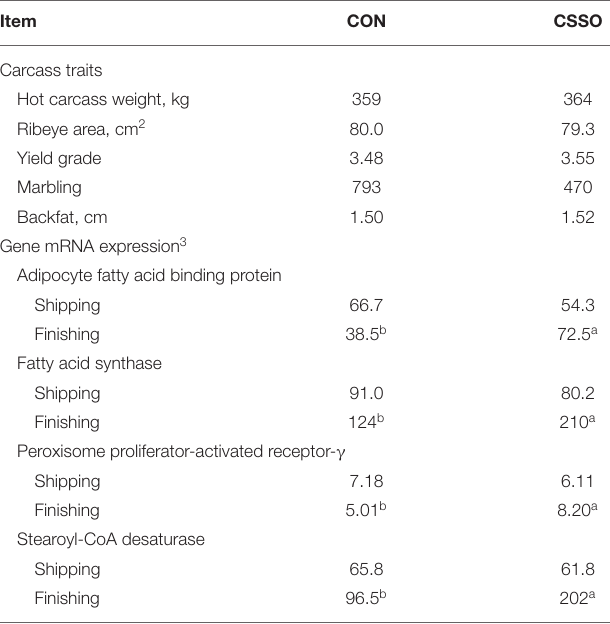
TABLE 2 | Carcass traits and expression of genes in the longissimus muscle associated from beef steers supplemented with Ca salts of soybean oil (CSSO) or prilled saturated fat (CON) from 2 to 4 months of age via creep feeding 1,2